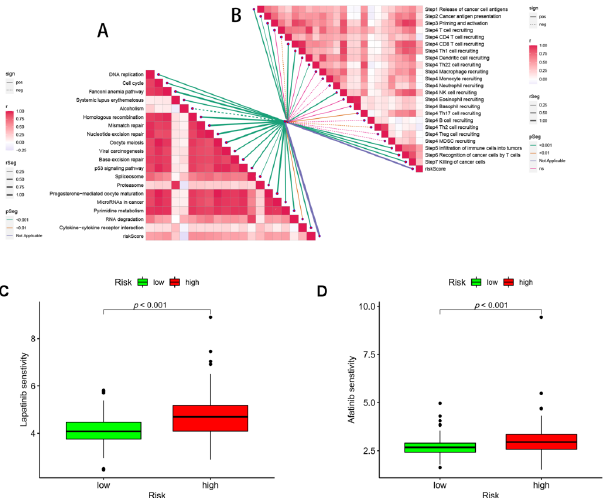
Figure 10. Prediction of immunotherapy and pharmacotherapy for different risk subgroups. ( A ) Correlation between risk score and ICB response signature, and ( B ) correlation between risk score and each step of the tumor immune cycle. IC50 values were calculated for patients in the high- and low-risk groups based on lapatinib ( C ) and afatinib ( D ) to assess the sensitivity of chemotherapeutic agents.